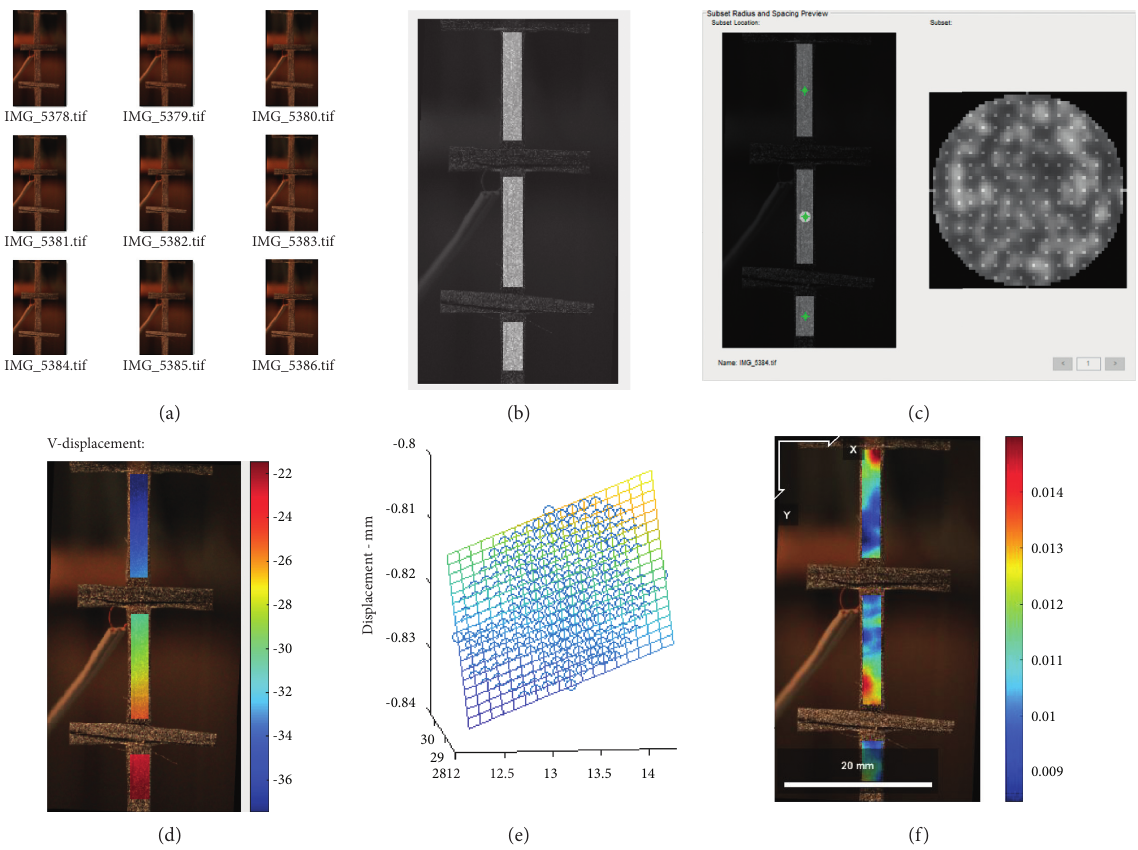
Figure 5: Procedure of DIC analysis in Ncorr program. (a) Import images to DIC program. (b) Define region of interest. (c) Define DIC parameters. (d) Unit conversion from pixel to real unit. (e) Strain calculation. (f) Strain result in vertical direction.